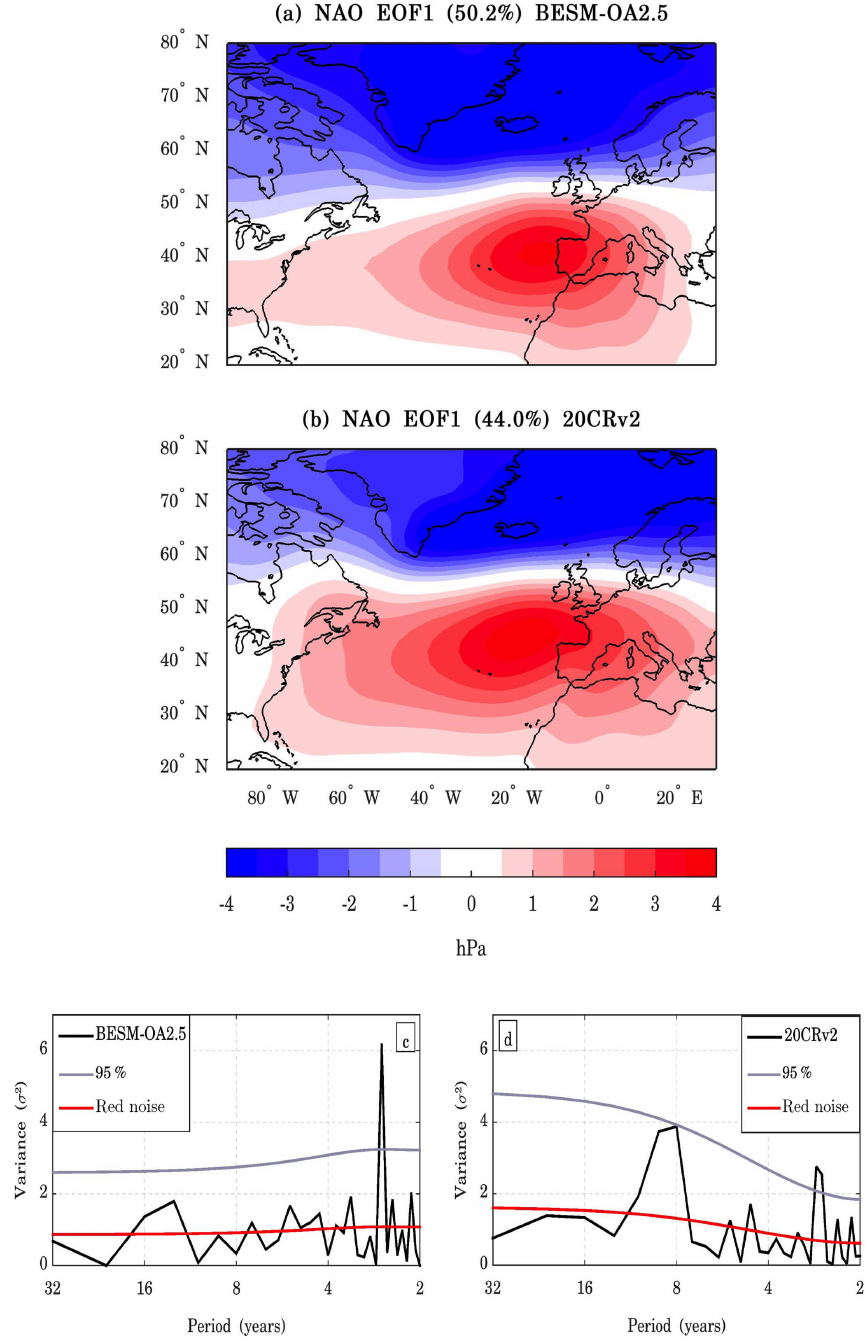
Figure 21. The leading EOF modes of the boreal winter (DJF) seasonal averaged sea level pressure (SLP) anomalies for the Euro-Atlantic region (20–80 ◦ N, 100 ◦ W–30 ◦ E) for (a) BESM-OA2.5 and (b) 20CRv2. The results are shown as the SLP anomalies regressed onto the corresponding normalized PC time series (hectopascal per standard deviation) for the period 1950–2005. The percentages of the variance explained by each EOF are indicated in the titles of the figures. The contour interval is 0.5hPa. Panels (c) and (d) show the power spectra of the leading PC time series of the North Atlantic Oscillation (NAO) pattern for BESM-OA2.5 and 20CRv2 reanalysis, respectively. The solid red line represents the theoretical red noise spectrum and the gray line represents the 95% confidence